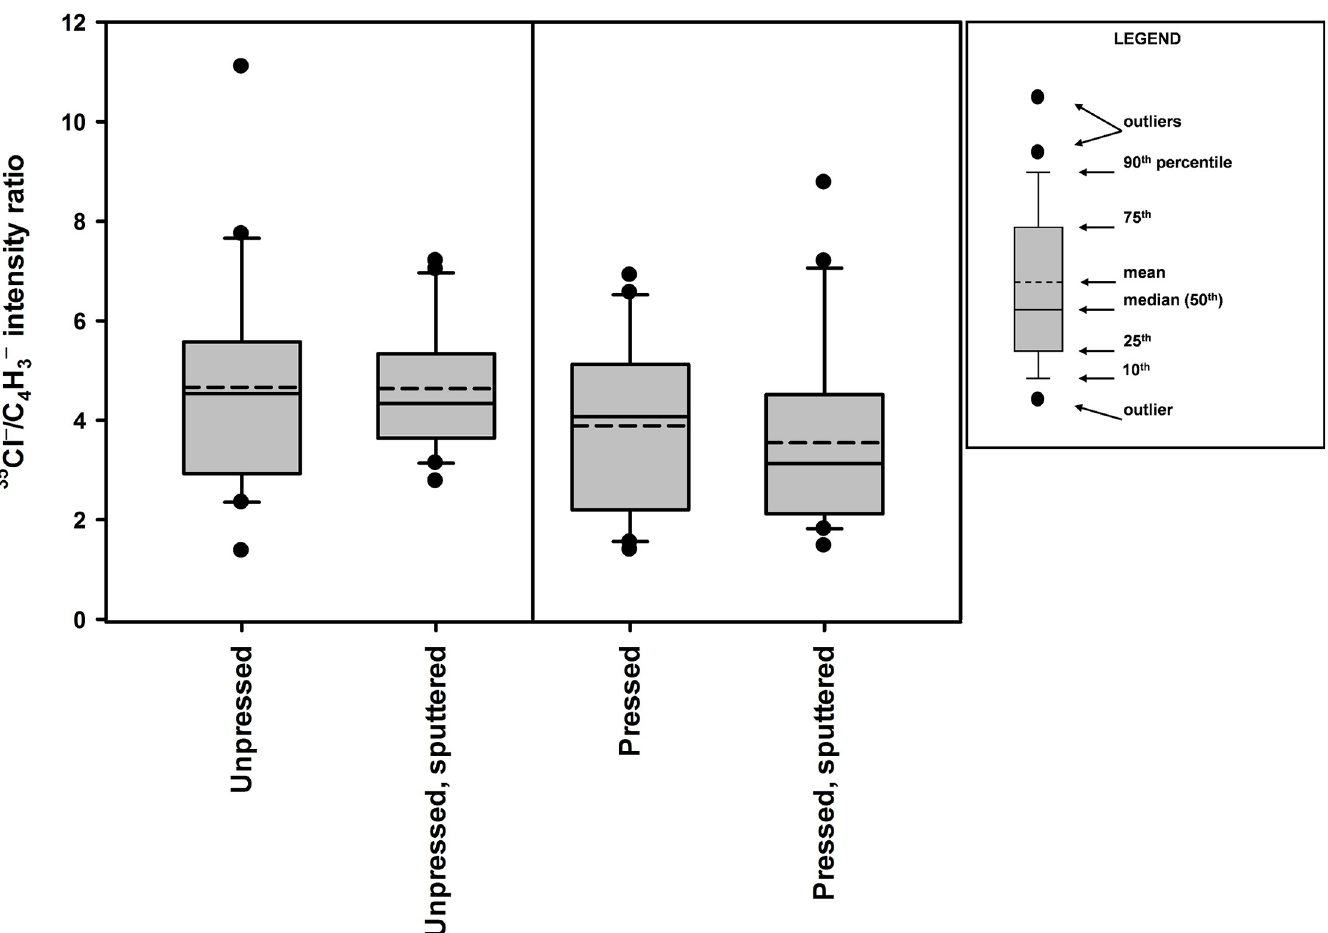
Fig 3. Box plots showing the effects of sample pressing and gentle sputtering on the 35 Cl - /C 4 H 3- secondary ion intensity ratios from Olyset fibers obtained from ToF-SIMS negative ion high resolution mass spectra. Each plot represents readings from 20 random locations on a single sample specimen. Analysis area of each location is 500 μ m × 500 μ